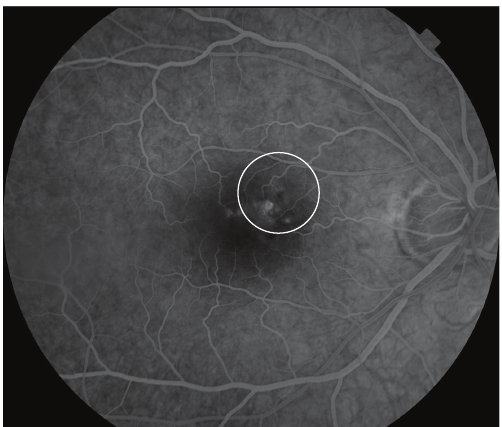
Figure 1: Fluorescein angiography of right eye demonstrating hy- perfluorescence and leakage at level of RPE. White circle depicts the area of fundus treated with PDT (1.5mm laser spot).